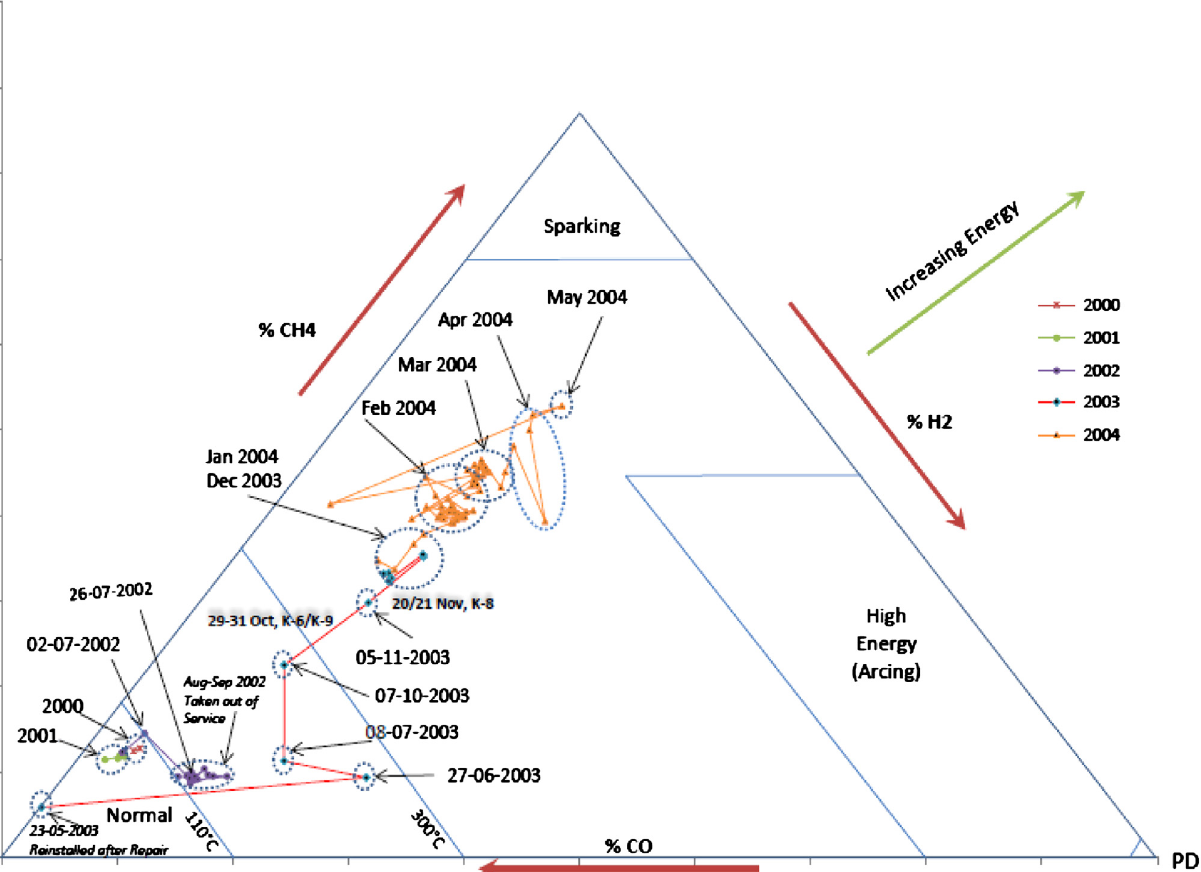
Fig. 5. Low-energy degradation triangle for transformer health assessment (Moodley & Gaunt